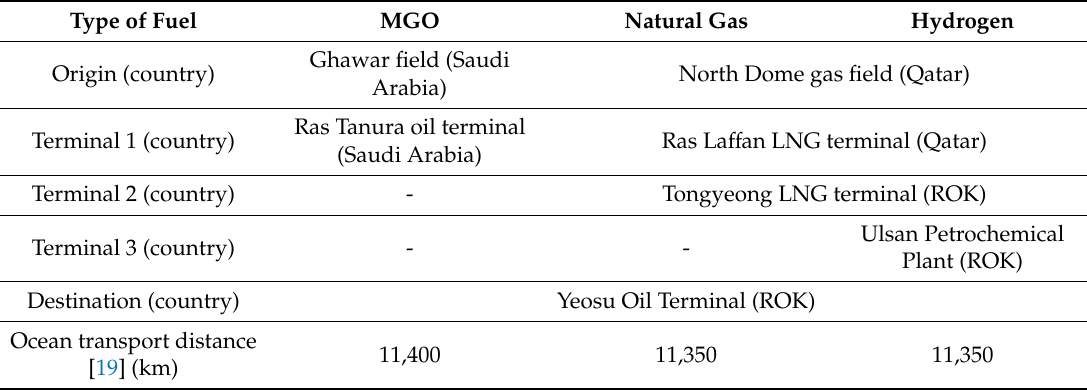
Table 2. Fuel transport pathways for each of fuels in the Well-to-Tank phase.